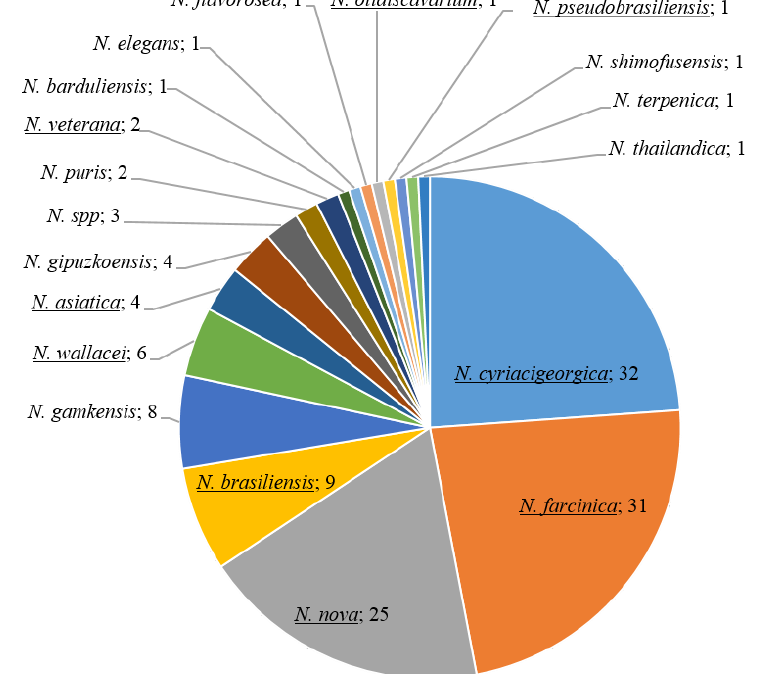
Figure 1. Species identification of 134 Nocardia isolates based on the sequencing of 16S rRNA gene and hsp65 genes. Underlined species were included in the VITEK ® -MS IVD V3.2 database.